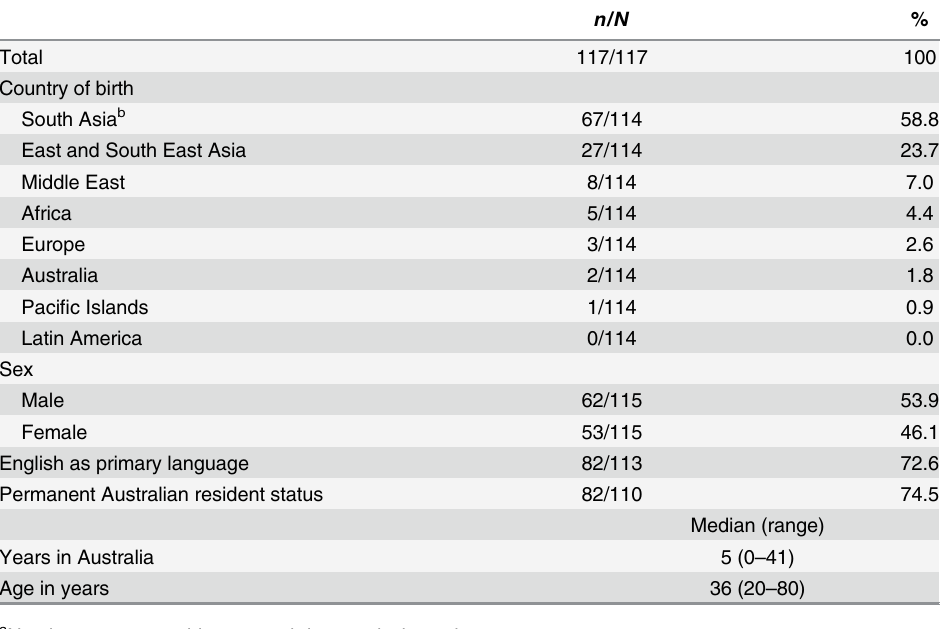
Table 1. Sociodemographic characteristics of EPTB cases. a